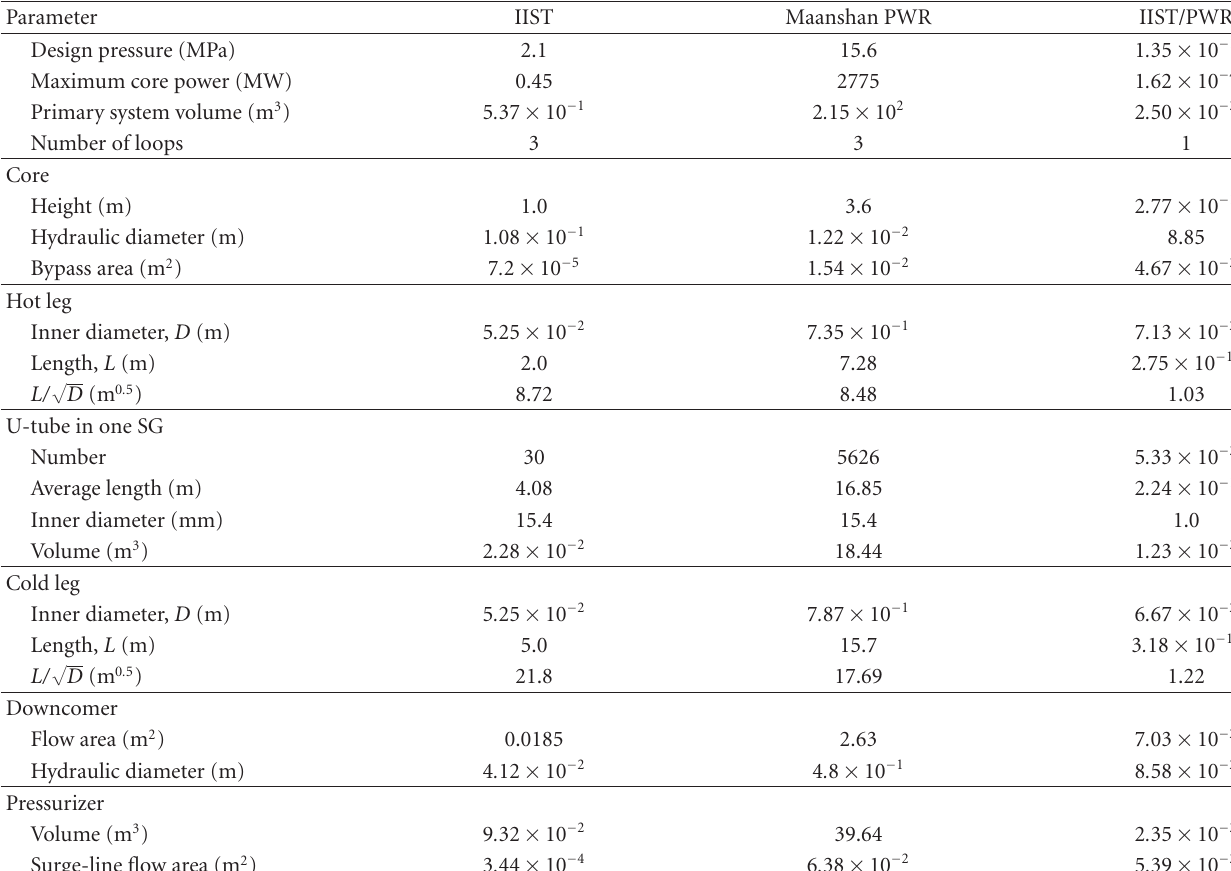
Table 1: The comparison of major parameters between IIST facility and the Maanshan NPP.